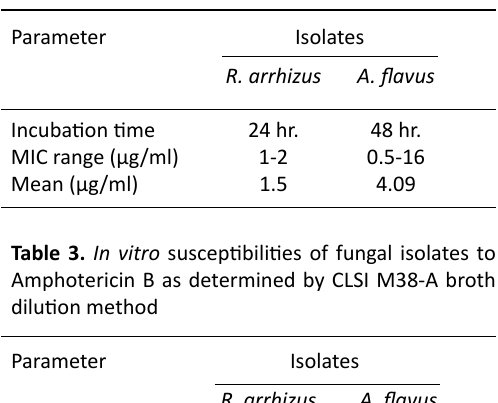
Table 2. In vitro susceptibilities of fungal isolates to Amphotericin-B as determined by E-test Parameter